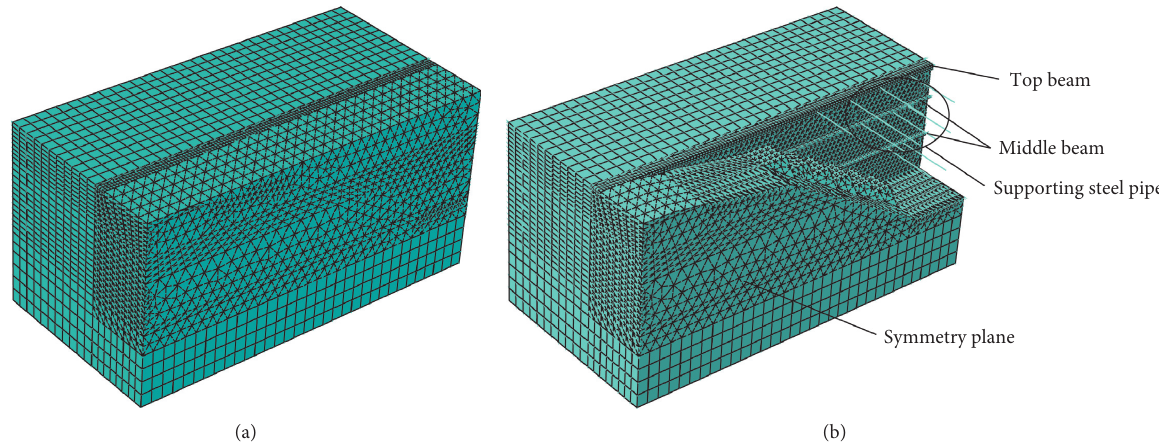
Figure 18: Model before and after excavation. (a) Before excavation. (b) After